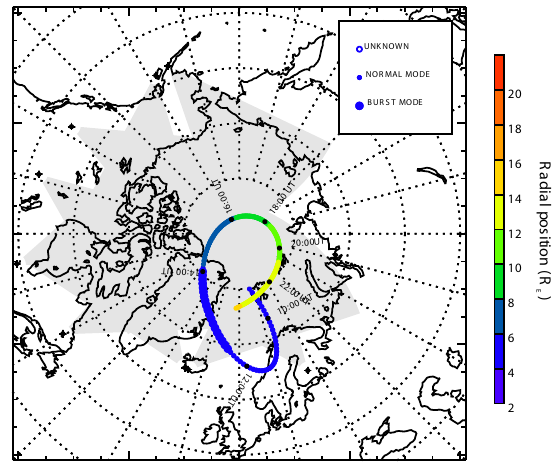
Fig. 2. The footprint of the cluster satellites on 22 August 2002. The radial geocentric position of the spacecraft is colour-coded ac- cording to the scale on the right. The footprint is calculated using the Tsyganenko 96 magnetic field model (solar wind pressure 2nPa, B y = B z =0nT, D st = − 50nT). The cluster footprint overlies the IM- AGE magnetometer chain during 10:00–12:00